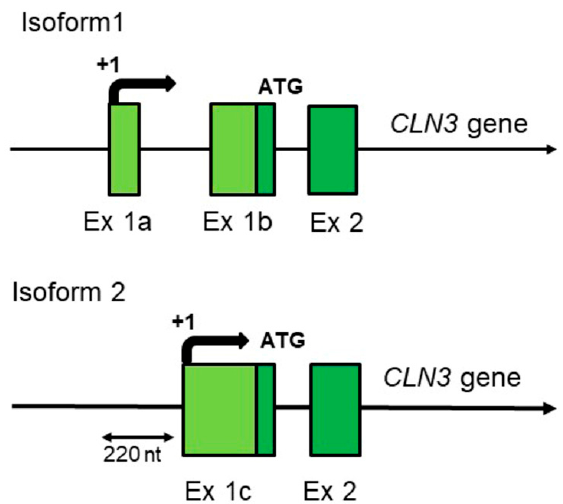
Figure 1. The schematic structure of two different full-length (complete) CLN3 mRNA isoforms transcribed from varying promoters of the CLN3 gene of Homo sapiens . Only regions corresponding to distinguished (differing) transcription start points and 2–3 of the first exons (out of 15–17) of the hCLN3 gene are shown. hCLN3 isoform 1 (transcript variant 1)—3832 nt (GenBank NM_001042432, UniProtKB/Swiss-Prot Q13286, CCDS 10632, Ensembl-Tr: ENST00000636147 (transcript: CLN3-244), protein—ENSP00000490105); hCLN3 isoform 2 (transcript variant 2)—1876 nt (GenBank NM_000086, UniProtKB/Swiss-Prot Q13286, CCDS 10632, Ensembl-Tr: ENST00000359984 (transcript: CLN3-205),